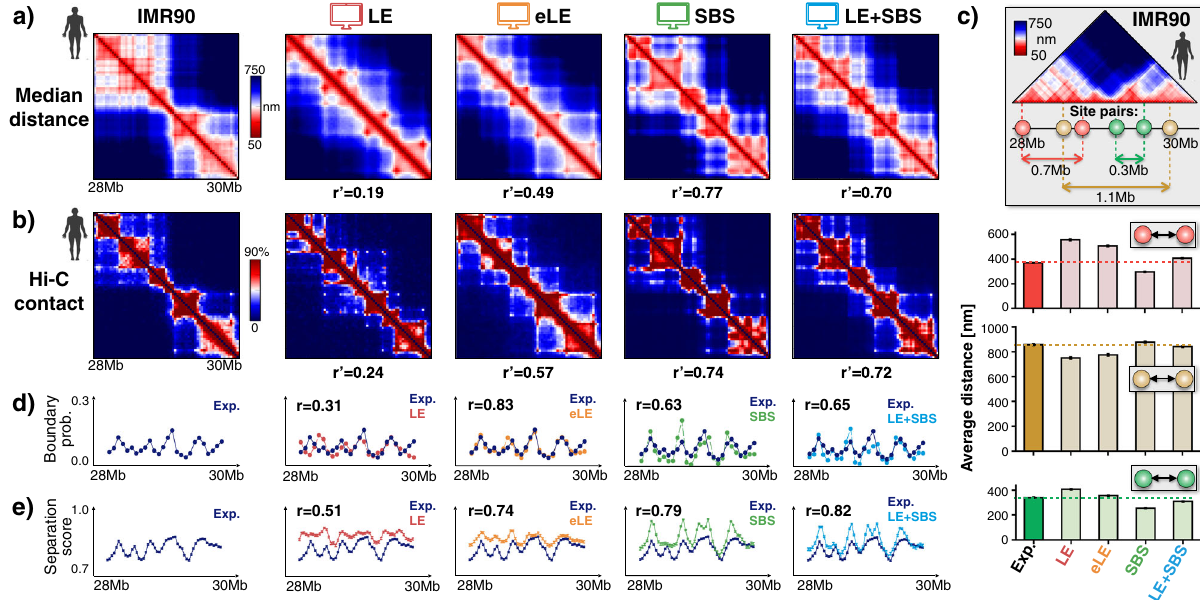
Fig. 2 Both loop-extrusion and phase-separation based models recapitulate bulk Hi-C and average microscopy data. a Microscopy median distance 6 and b bulk Hi-C 15 data are compared to the corresponding model results in the IMR90 locus. The different models have high genomic distance-corrected Pearson correlations ( r ', reported below their matrix) with the experiments. c The model derived average distances are reported for three speci fi c pairs of sites: (i) separated by a strong TAD boundary (yellow pair); (ii) connected in loops within a TAD (green) and (iii) across a TAD boundary (red). d The average genomic boundary probability across single-molecules and e the separation score are also well recapitulated by the models (error bars indicate 95% con fi dence intervals). n = 1000 independent single-molecule conformations for each model. Source data are provided as a Source Data fi